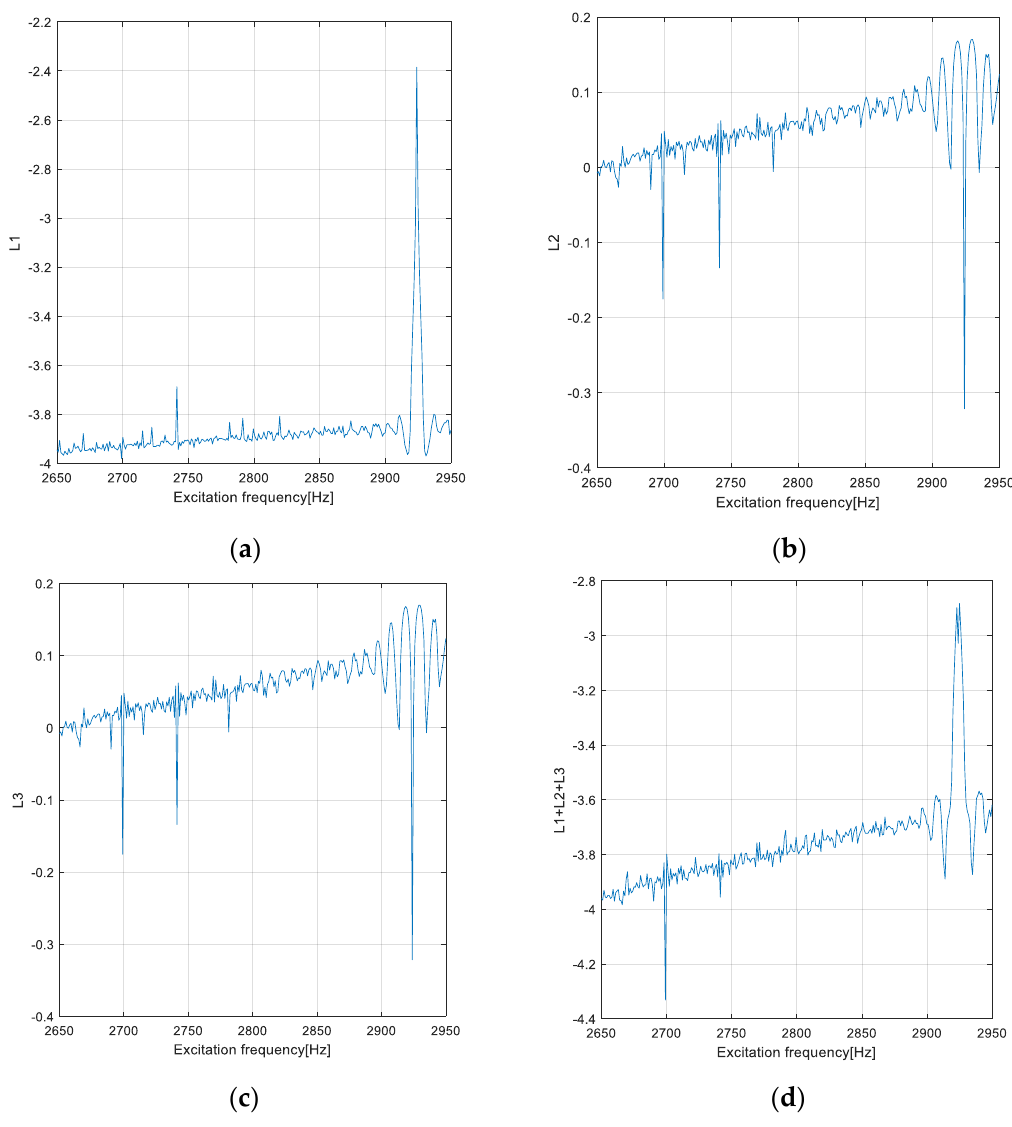
Figure 24. Lyapunov exponents of NFTV for DOE3, 0 To certify using a qualitative method that the DIE1 and DOE3 have NFTV in the PPRR of chaotic type, MATLAB software was developed based on DSOE (29) for DIE1 and on DSOE (30) for DOE3, to represent the Poincar é Maps that represents the intersection of the orbits in the phase portraits with an orthogonal surface at equal periods (N number of points), using the mathematical procedure presented in [32] (p. 194). The Poincar é map represents saddle points or saddle separatrices images if the vibration motion is periodic or quasi-periodic. Figure 25 is presented the PM for DIE1 when ξ = 1.6 · 10 − 3 , = 3066.5 Hz (see Equation (27), Figure 9, and Table 1), β η 1 10,000, and 1000 sections of orthogonal surface to the orbits in the phase portrait